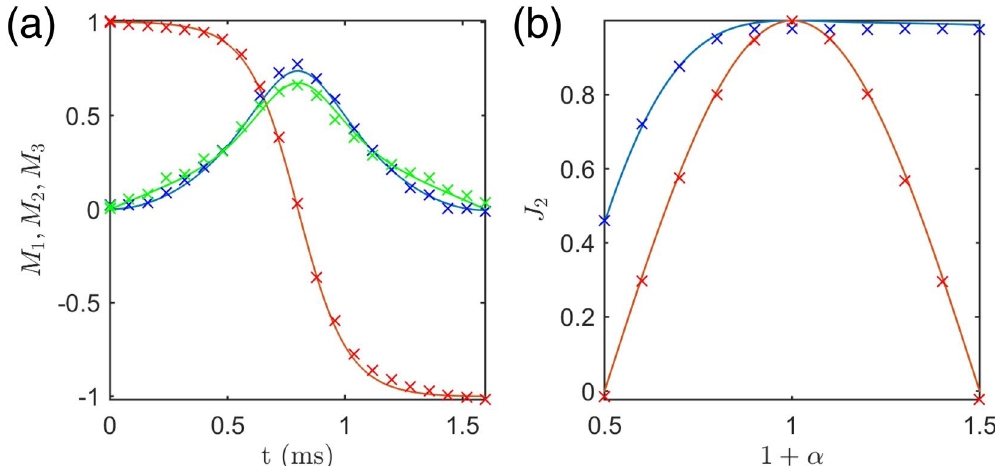
Figure 5. Experimental implementation of the TRE pulse. The panels ( a,b ) represent respectively the trajectories of the components of the Bloch vector (2: red or dark gray, 3: blue or black, 1: green or light gray) and the robustness of J 2 with respect to the α - parameter. A rectangular π pulse is used in panel ( b ) for comparison (red or dark gray). The experimentally measured points and the simulated trajectories are represented by crosses and solid lines, respectively. Experimental details can be found in the main